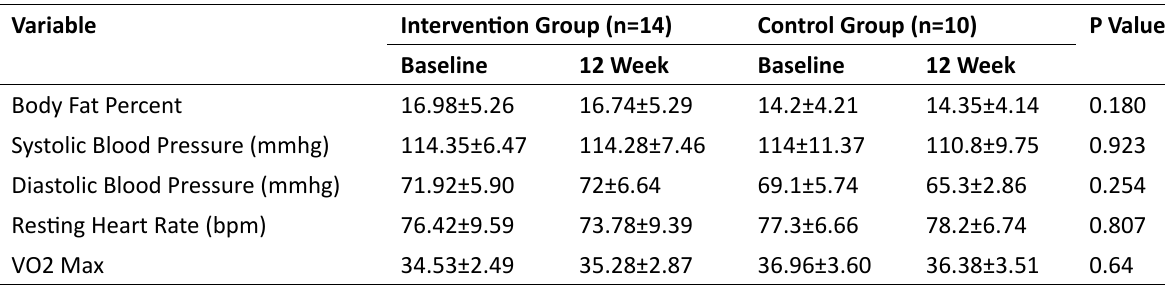
Table 1. Comparison at Baseline between Intervention and Control Group (T Test)